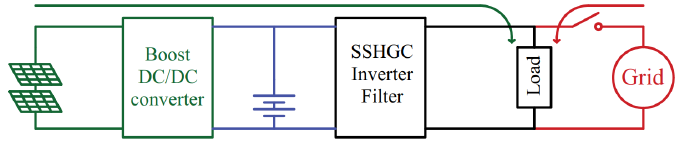
Figure 9. Power operation mode